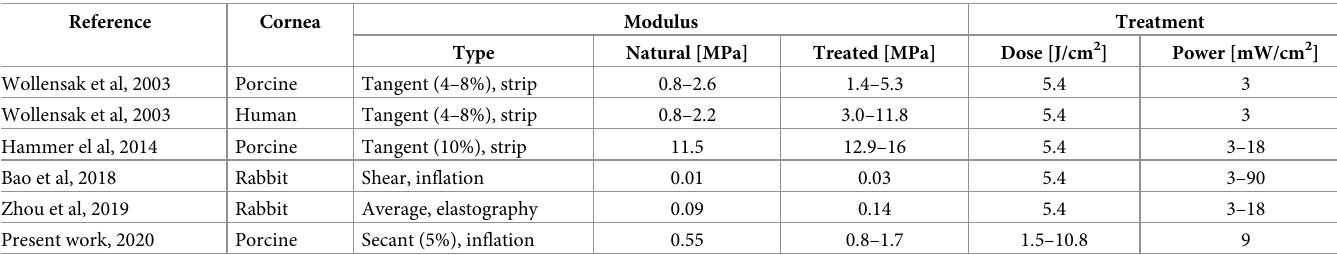
Table 5. Comparison of the experimental elastic modulus obtained in previous works concerning animal and human CXL